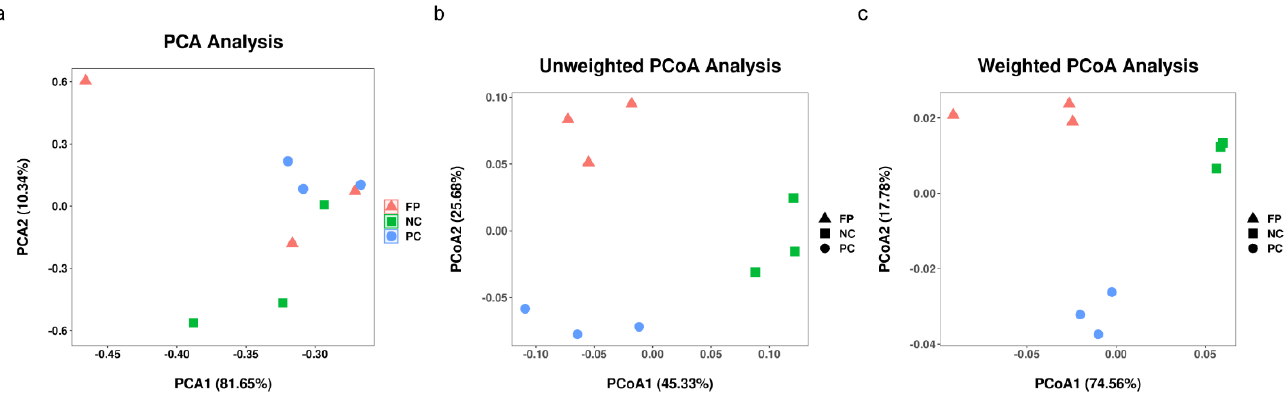
Figure 1. Advanced analysis of the bacterial communities of cecal digesta. ( a ) Principal component analysis of the cecal digesta of basal diet without treatment (NC), basal diet plus coccidial challenge (PC), and basal diet plus the coccidial challenge and 1 g/kg of B. licheniformis -fermented products (FP) (n = 3). Principal coordinate analysis of quantitative traits (unweighted UniFrac distances) ( b ) and qualitative traits (weighted UniFrac distances) ( c ) of the cecal bacterial communities from NC, PC, and BLFP (n = 3).